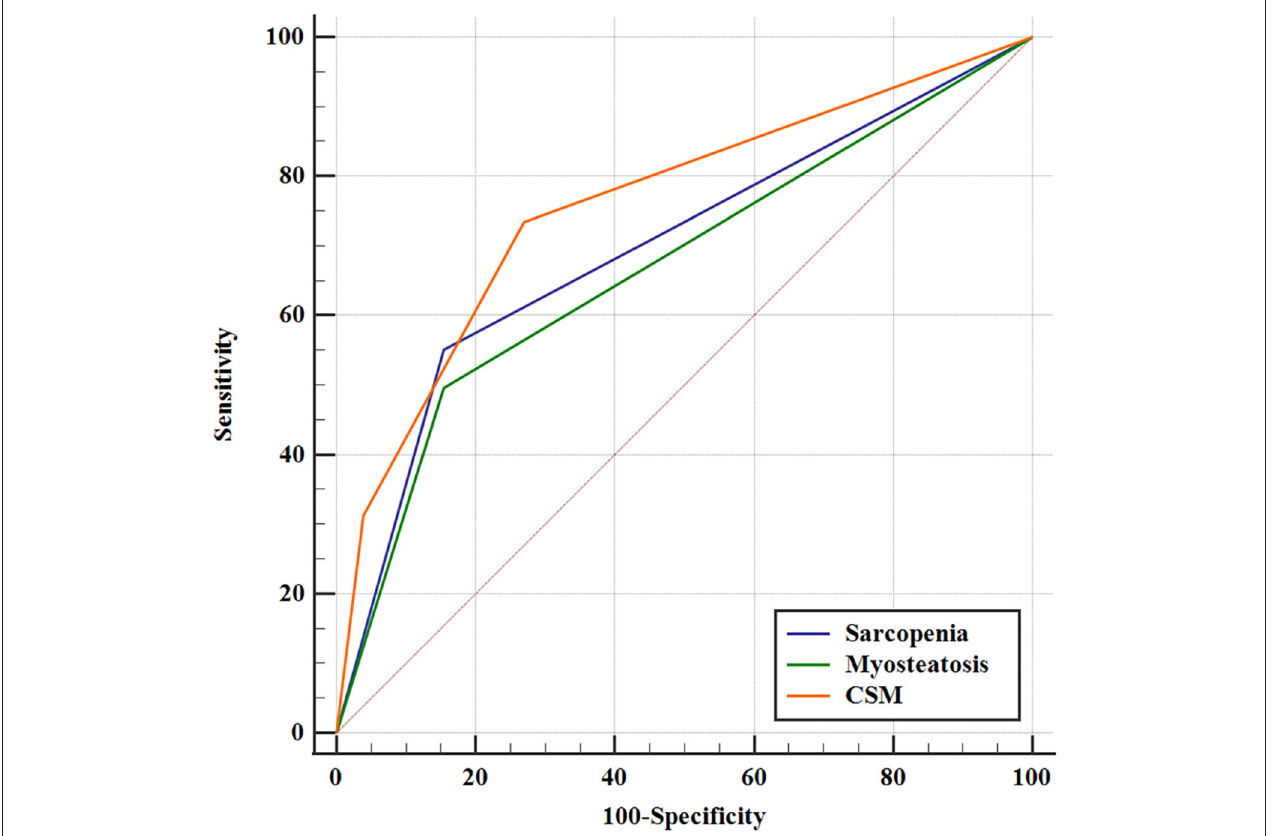
FIGURE 6 | The predictive value of sarcopenia, myosteatosis, and CSM by ROC curves.